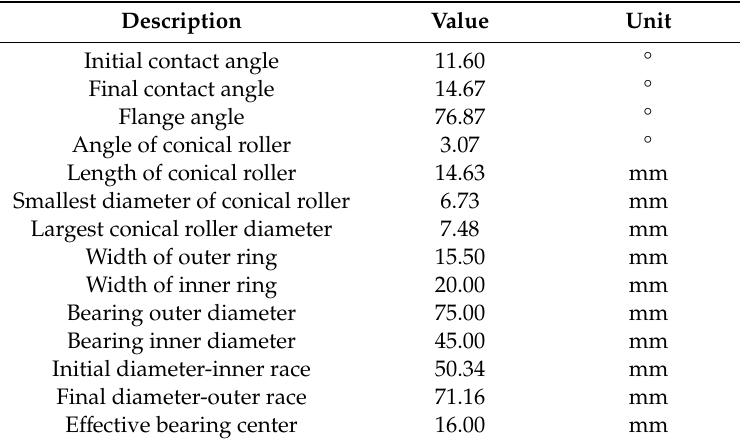
Table 2. Main dimensions of the bearing studied.